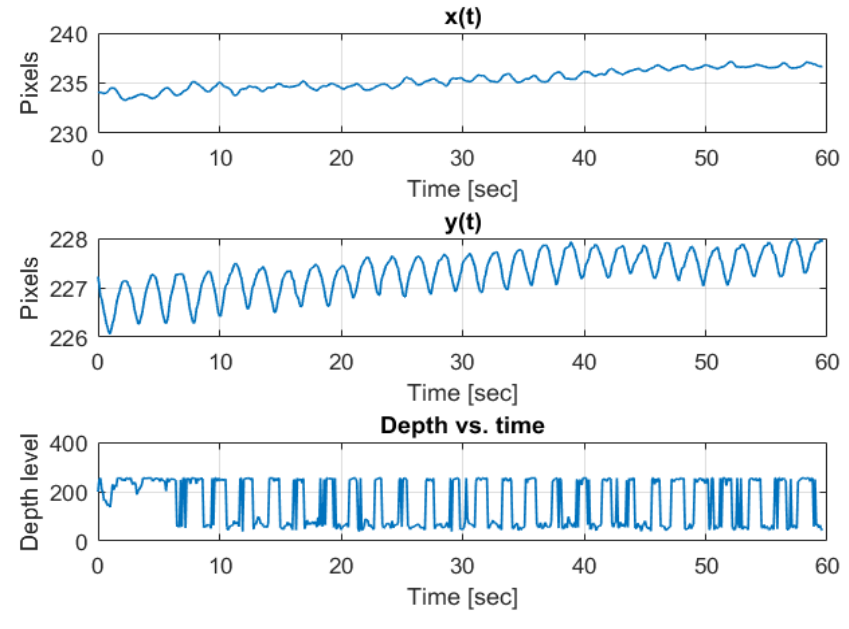
Figure 3. Pre band-pass filtering example of three axes (x, y, depth) breathing